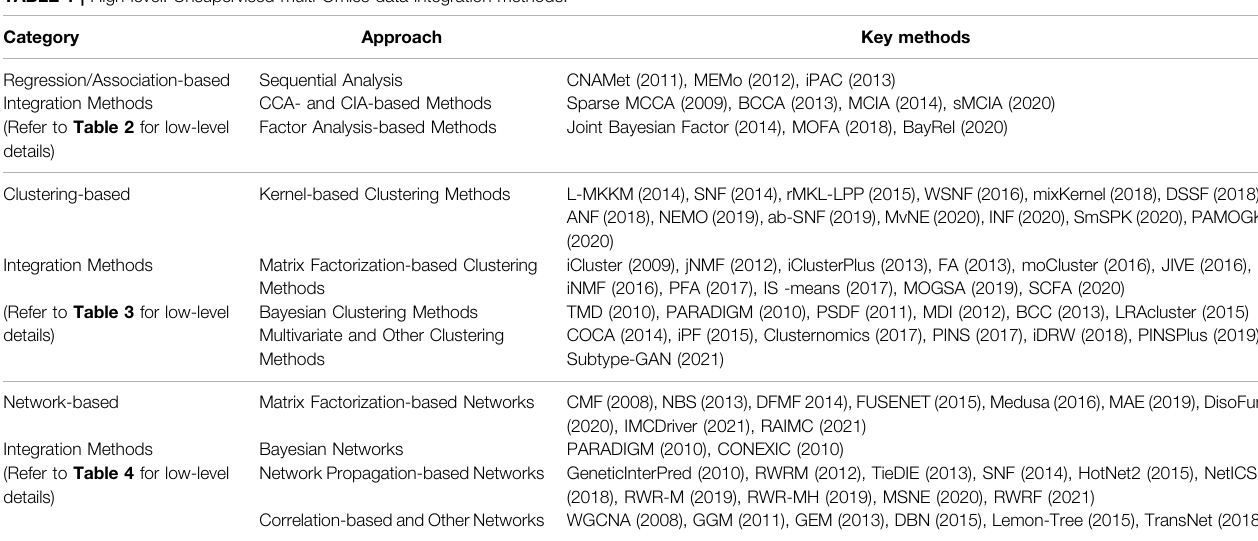
TABLE 1 | High-level: Unsupervised multi-Omics data integration